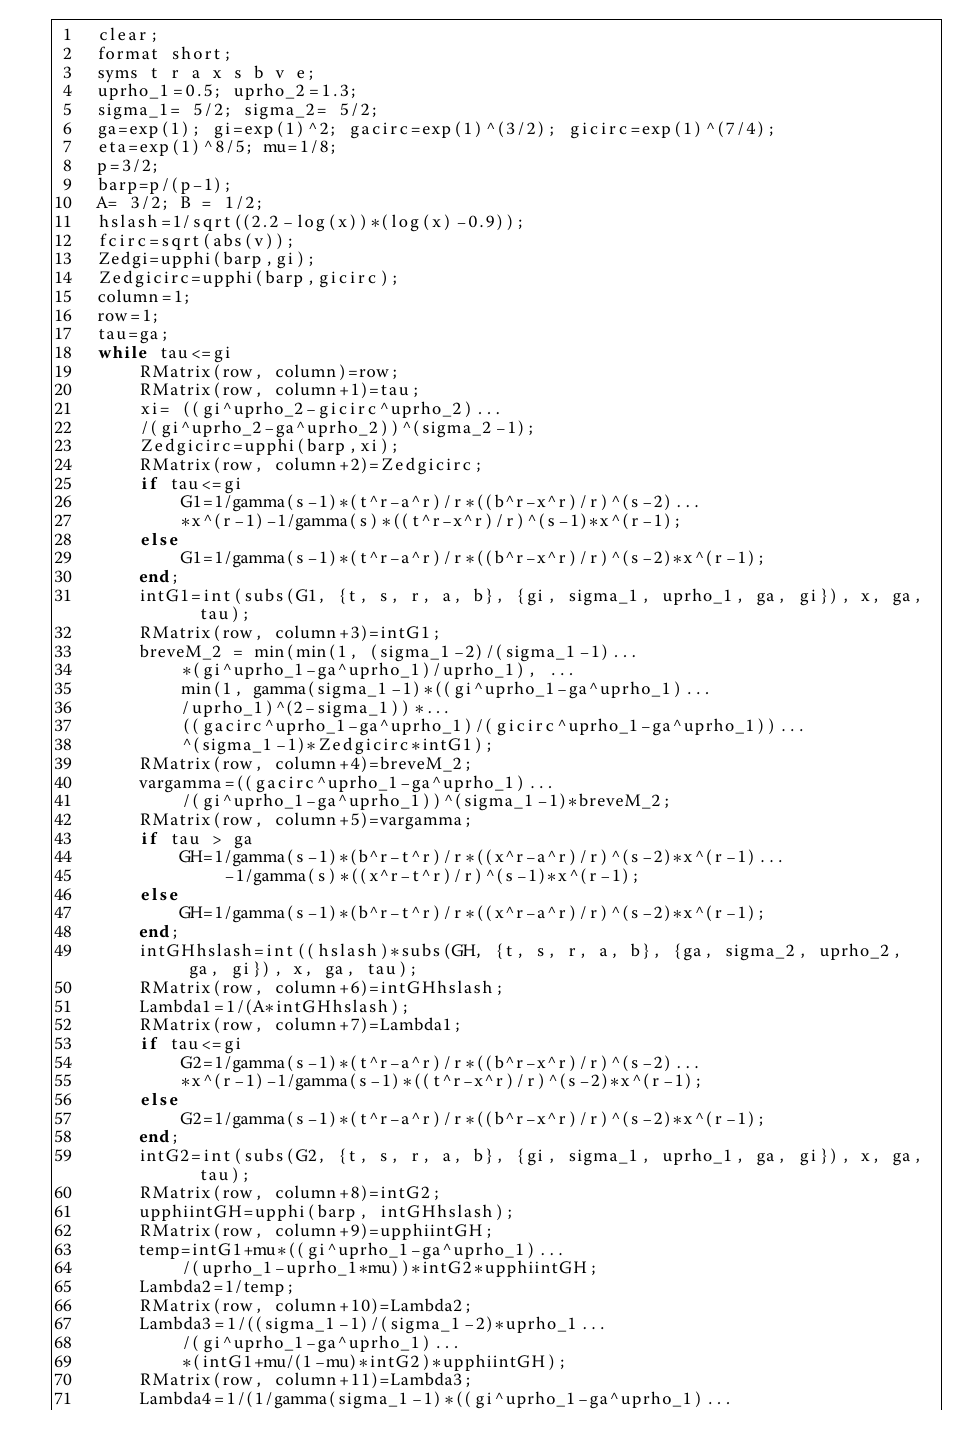
Algorithm 1 (MATLAB lines for calculation of variable values in Example